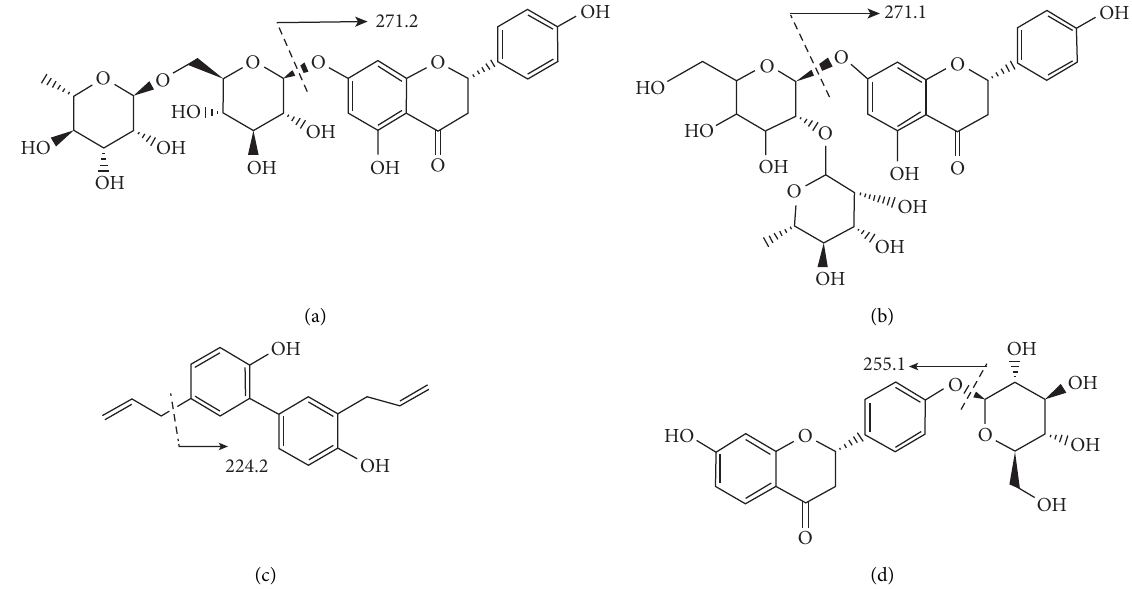
Figure 1: The chemical structures and fragmentations of narirutin (a), naringin (b), honokiol (c), and liquiritin (IS)